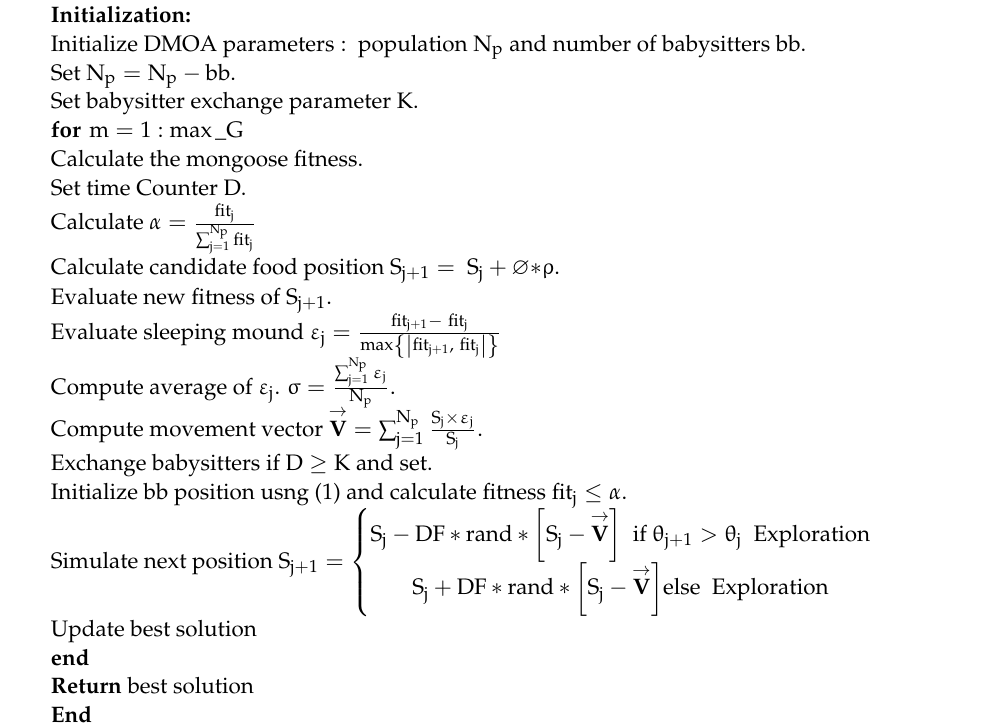
Algorithm 1: Pseudo-code of the